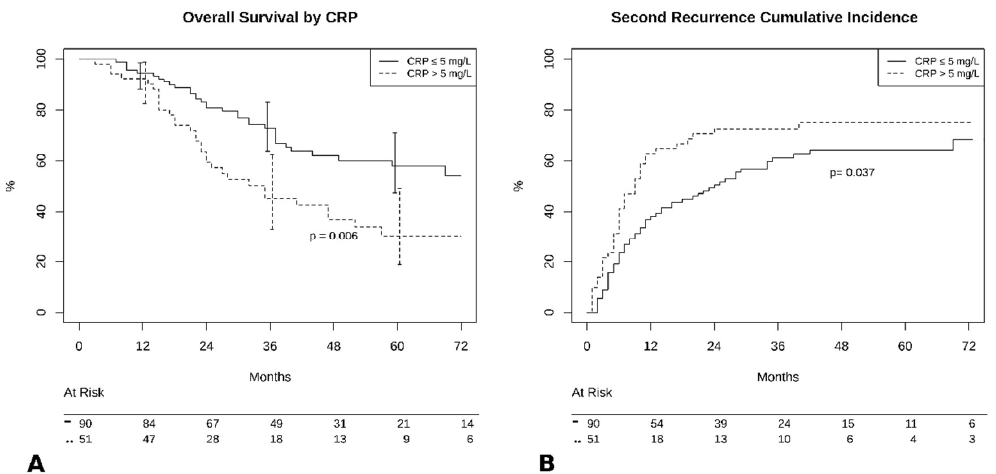
Figure 2. ( A ) Overall survival by C-reactive protein (CRP) groups. ( B ) Cumulative incidence of recurrence by CRP groups.